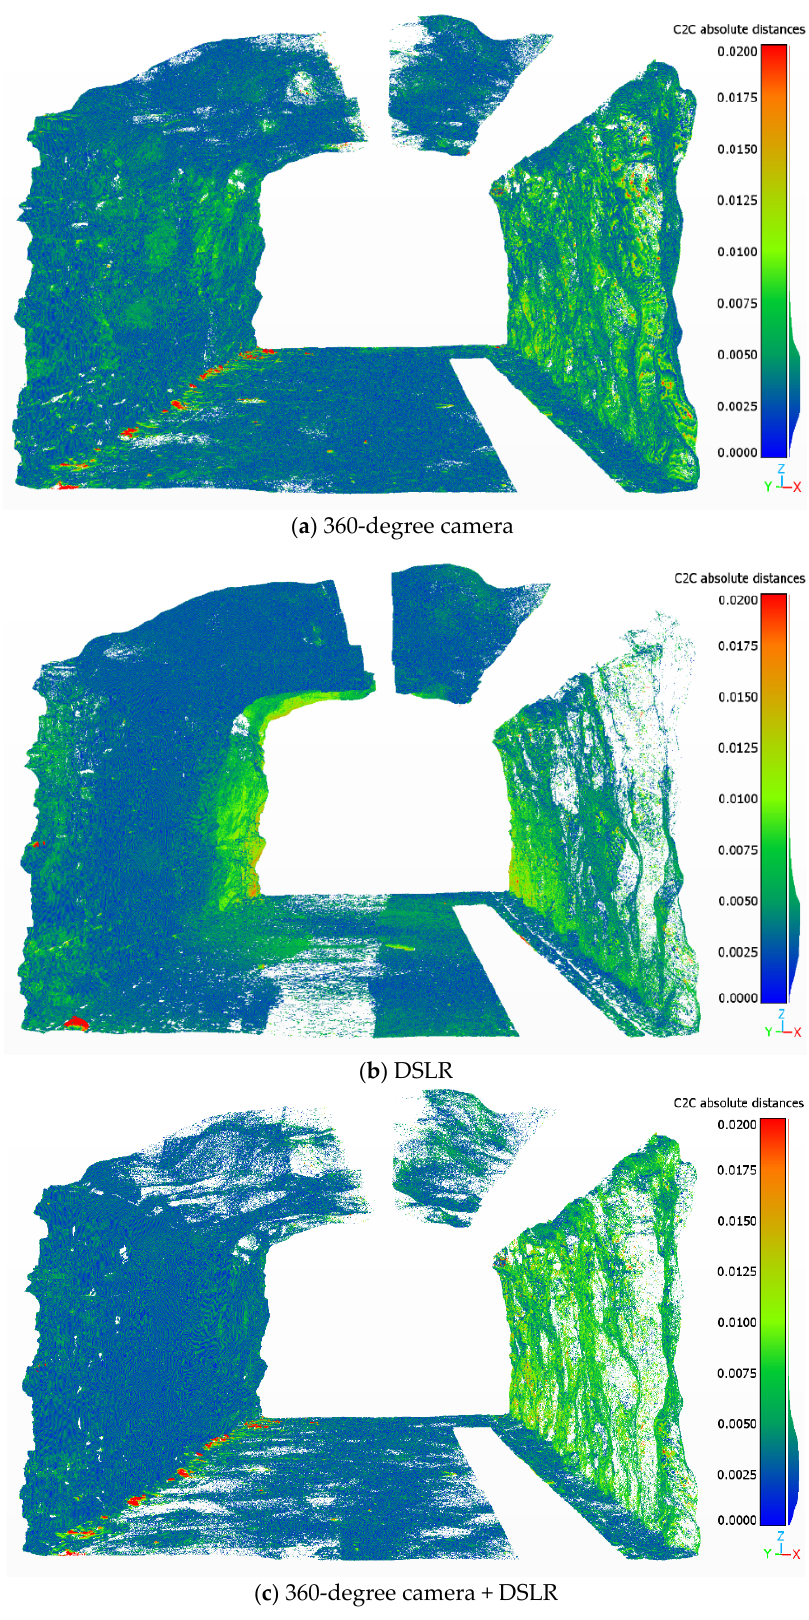
Figure 11. Cloud ‐ to ‐ cloud (C2C) distance between the reference TLS laser scan and the 3D point cloud of the tunnel wall digitized with: ( a ) 360 ‐ degree camera, ( b ) DSLR, and ( c ) 360 ‐ degree camera cloud of the tunnel wall digitized with: ( a ) 360-degree camera, ( b ) DSLR, and ( c ) 360-degree camera with HQ images of the tunnel wall. with HQ images of the tunnel